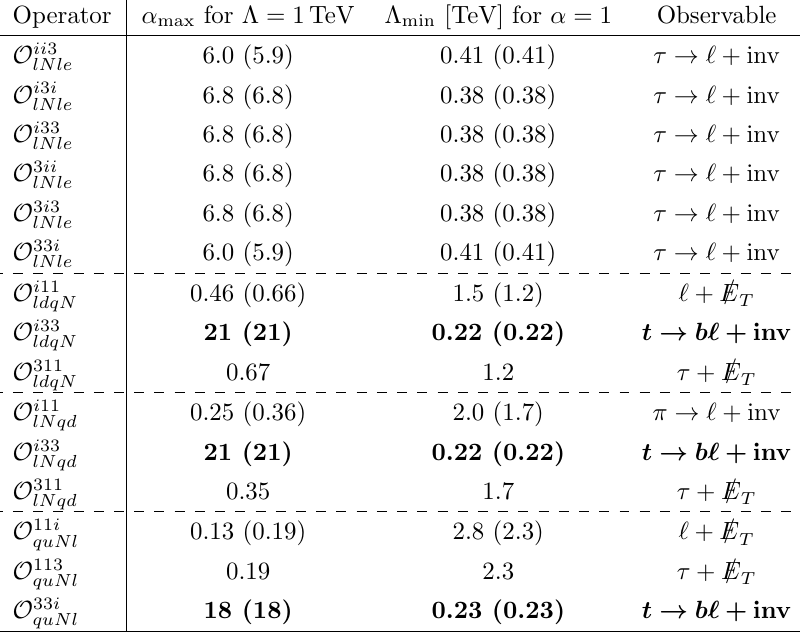
Table 7 . Maximum (minimum) value of (cid:11) ((cid:3)) for (cid:3) = 1 TeV ( (cid:11) = 1) allowed by the observables quoted in the last column for LRRL operators. The numbers outside (inside) the parentheses refer to ‘ = e ( (cid:22)